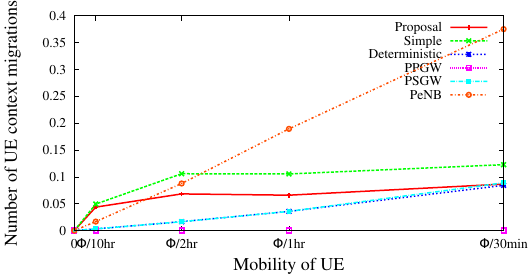
Figure 5: Average delay in Scenario 1 ( ρ = 1 )